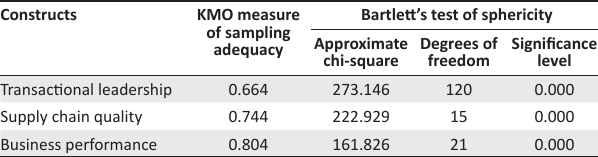
TABLE 2: The Kaiser–Meye–Olkin measure and the Bartlett test results.